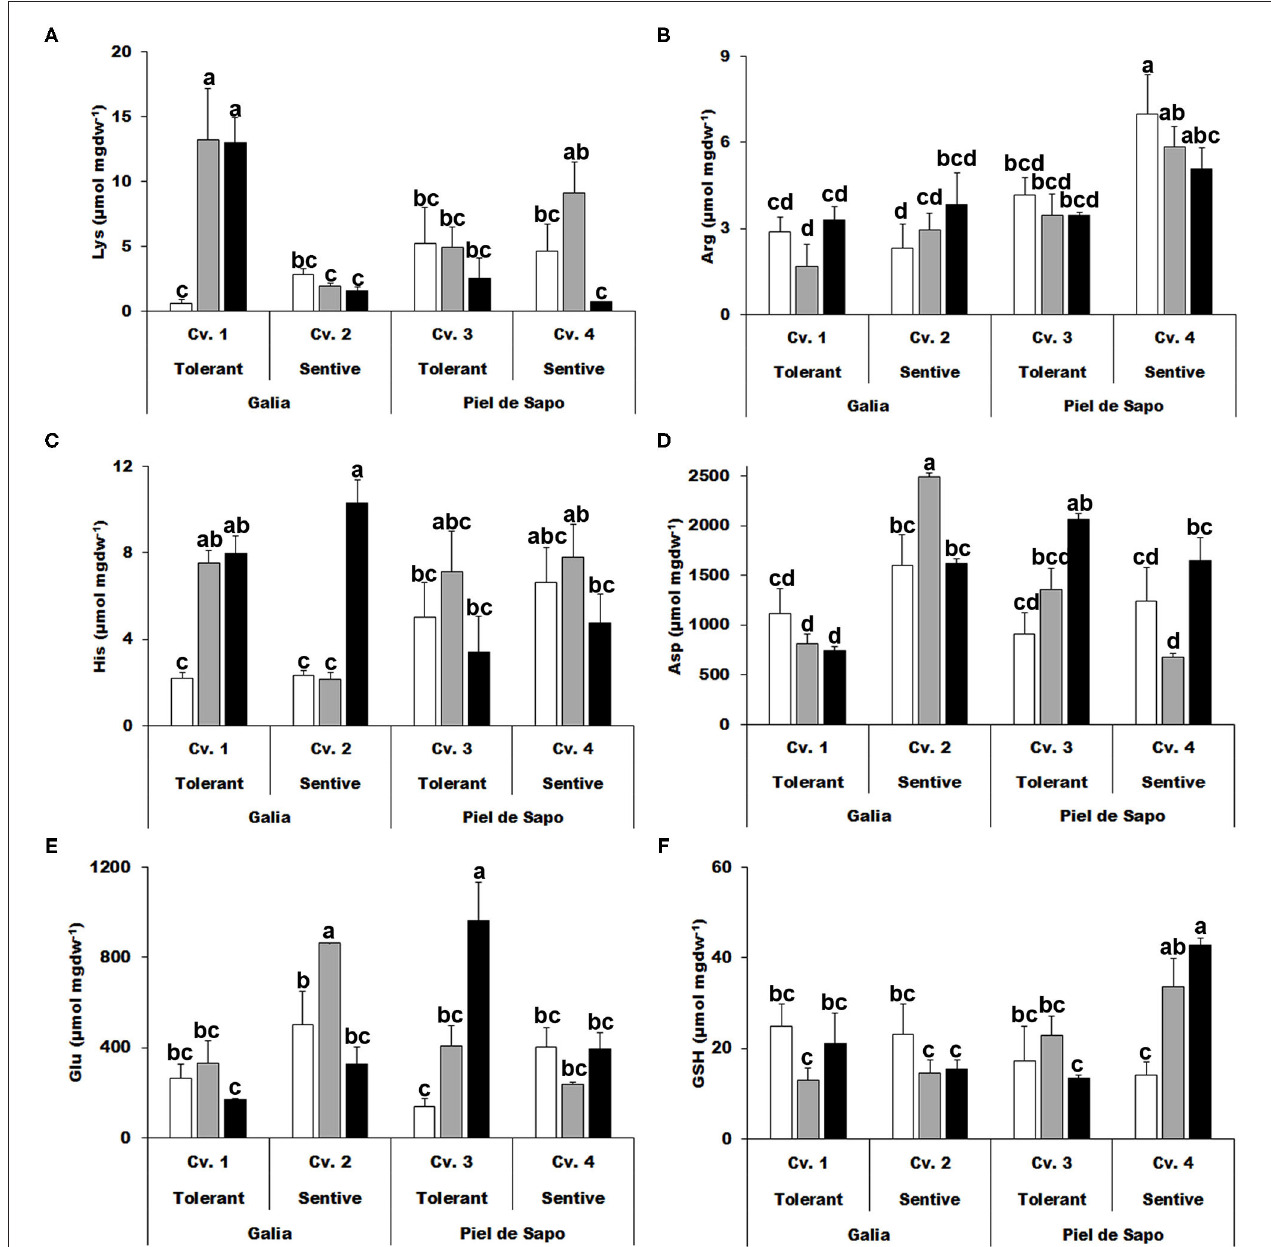
FIGURE 4 | Charged amino acids. Lysine (Lys) (A) ; arginine (Arg) (B) ; histidine (His) (C) ; aspartic acid (Asp) (D) ; glutamic acid (Glu) (E) ; and glutathione (GSH) (F) concentrations of Galia tolerant genotype (Cv. 1), Galia sensitive genotype (Cv. 2), Piel de Sapo tolerant genotype (Cv. 3), or Piel de Sapo sensitive genotype (Cv. 4) under control (white bars), salt stress (gray bars), and drought stress (black bars) conditions. Data with different letters differ significantly ( p < 0.05), as determined by Duncan’s MRT test ( n = 3). Scale bars are mean ± SE. Experiment was replicated with similar